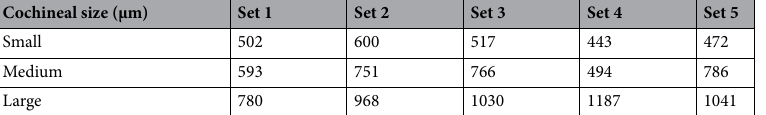
Spectral bandwidth